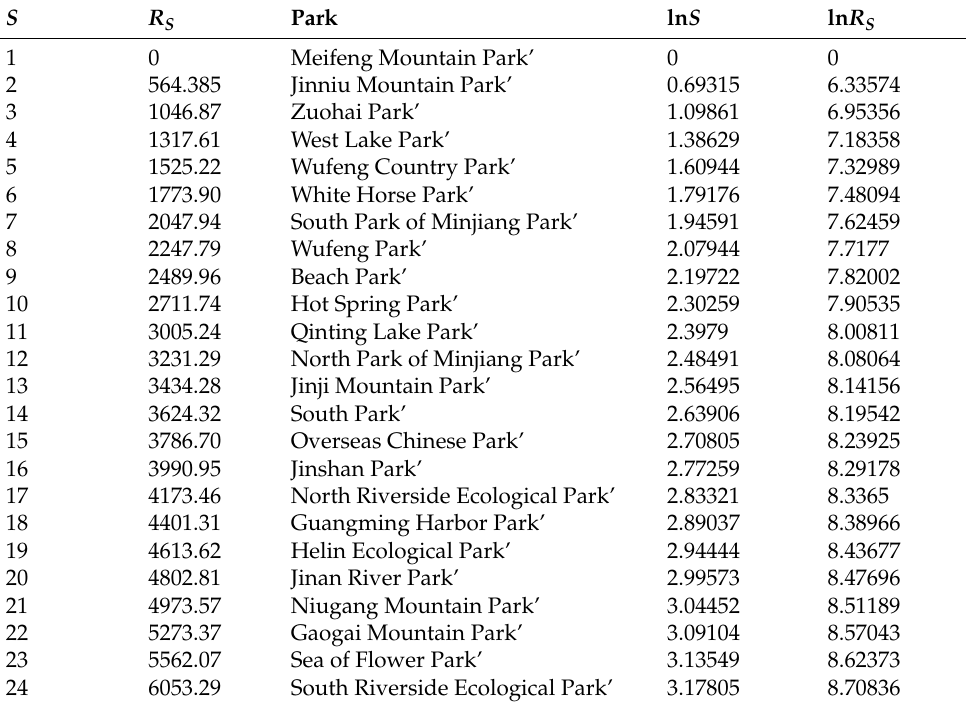
Table A4. Park system aggregation dimensions based on Meifeng Mountain